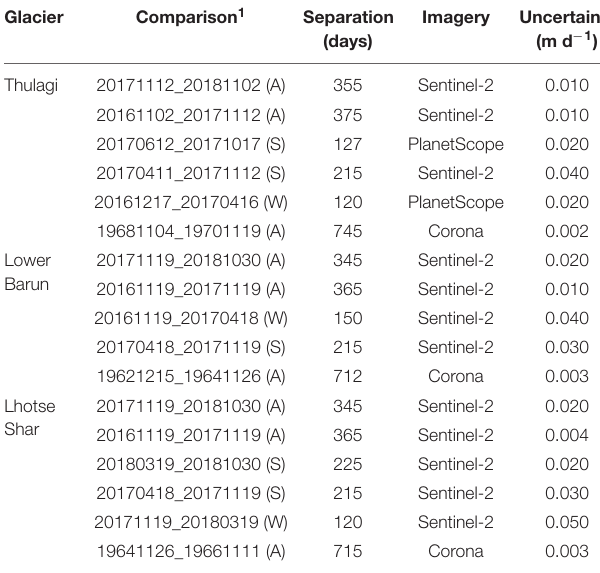
TABLE 2 | Glacier velocity